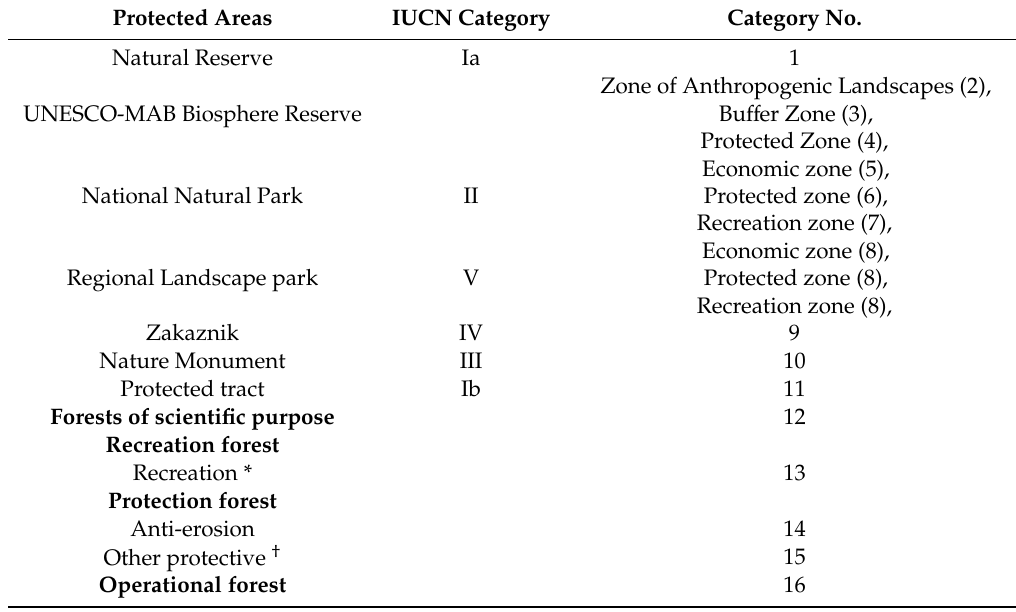
Table 1. Categories of forest protection in Ukraine.